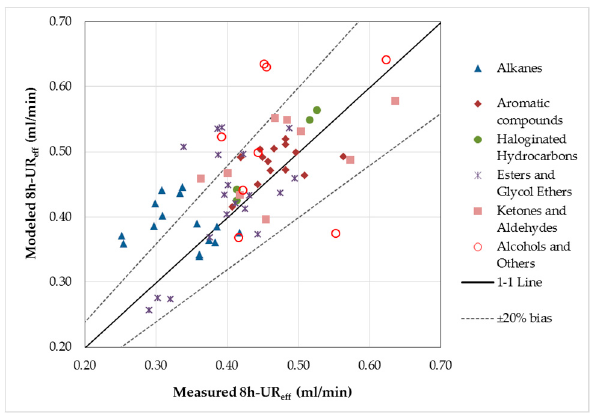
Figure 3. Comparison of modeled and measured 8h-UR eff values in occupational sampling.